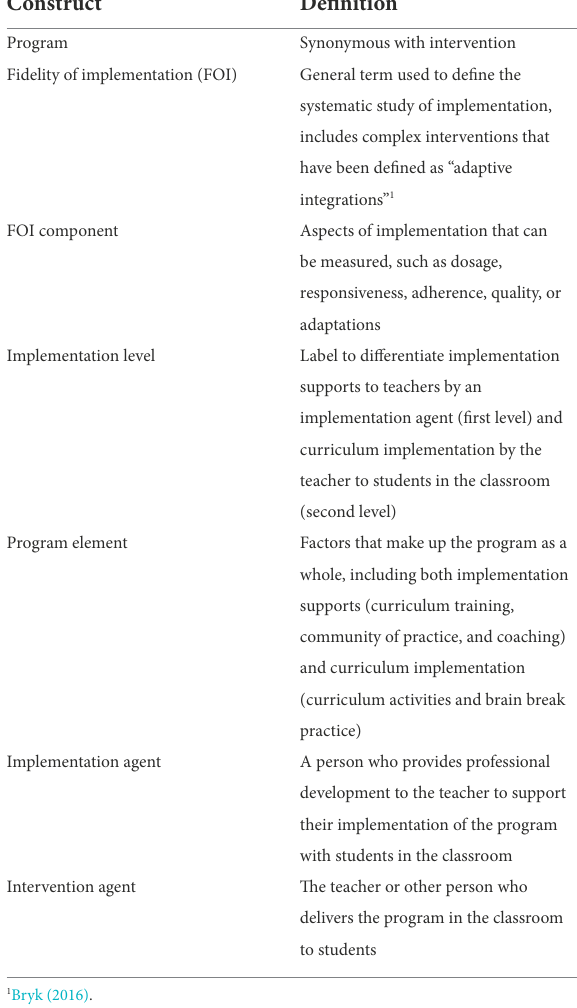
TABLE 1 Definitions of